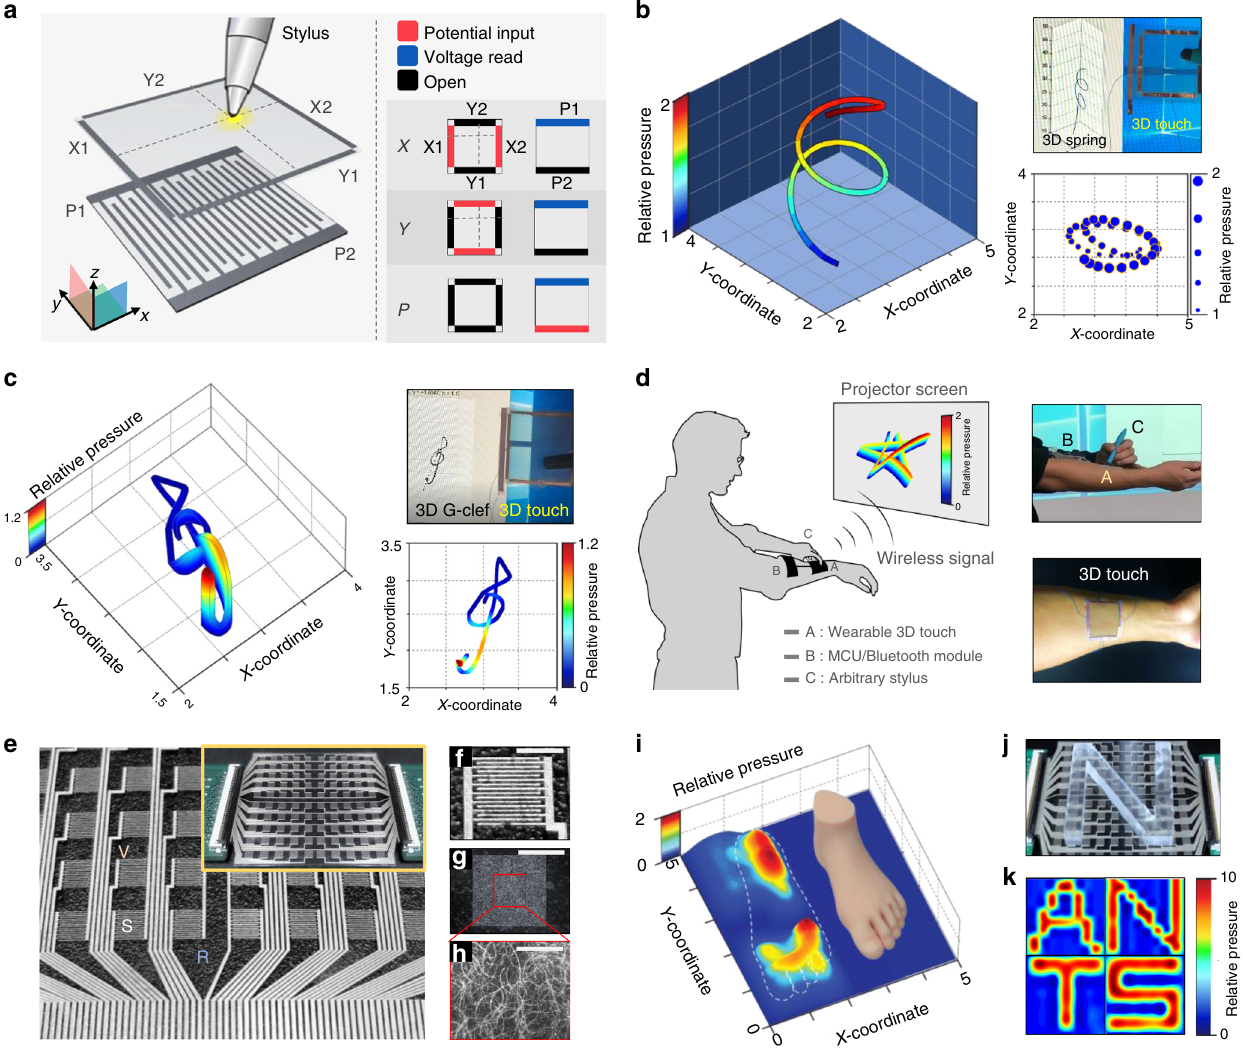
Fig. 4 3D touch applications. a Working mechanism of six-wire transparent 3D touch. b 3D structured spring drawn by altering pen pressure: 3D touch was directly attached to a monitor while the spring is simultaneously displayed on the left. Also the pen pressure can be displayed as different line thicknesses as depicted on the right corner. c 3D structured G-clef drawn by 3D touch: 3D touch was directly attached to the monitor while the G-clef is simultaneously displayed on the left. The 2D fi gure of the G-clef is shown on the right corner. d Demonstration as a wearable and wireless 3D touch: Illustration of drawing 3D structured star and the real image of the attached system on forearm. e Picture of the 10 × 10 sensory array and the inset shows the entire system connected to the analyzer. f Magni fi ed image of a single cell containing comb-like electrode. Scale bar, 3 mm. g The AgNW layer. Scale bar, 3 mm. h SEM image of the AgNW layer. Scale bar, 150 μ m. i 3D pressure distribution of an arti fi cial foot. Exact scale of the foot is compared next to the distribution. j Sample image of PDMS block forming the letter ‘ N ’ placed on top of the sensor array. k Pressure con fi guration showing the letters ‘ A ’ , ‘ N ’ , ‘ T ’ , and ‘ S